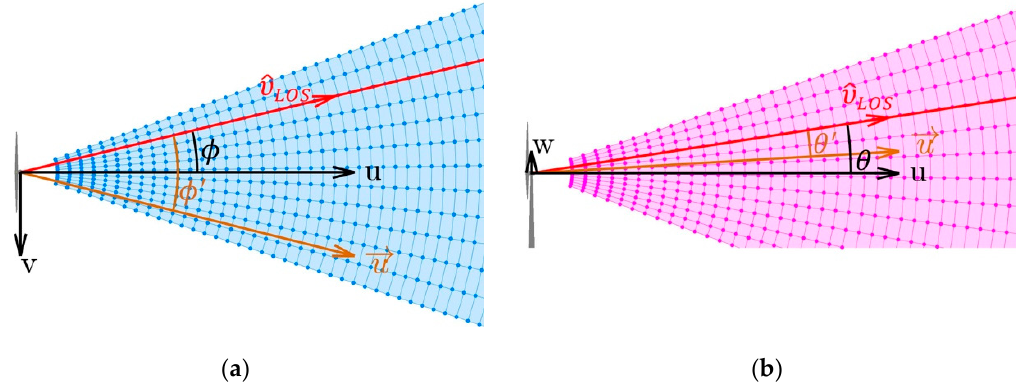
→ u , the azimuth angle,